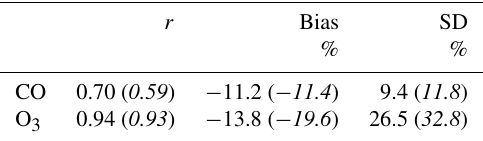
Table 1. Statistics of GC vs. IASI UTLS CO and O 3 columns com- parison over the 10 ◦ S–40 ◦ N and 0–160 ◦ E domain for monthly av- erages during the MJJASO period. Figures are given for GC pro- files smoothed with the averaging kernels (GCwAvK) and figures in italic between brackets correspond to GC raw